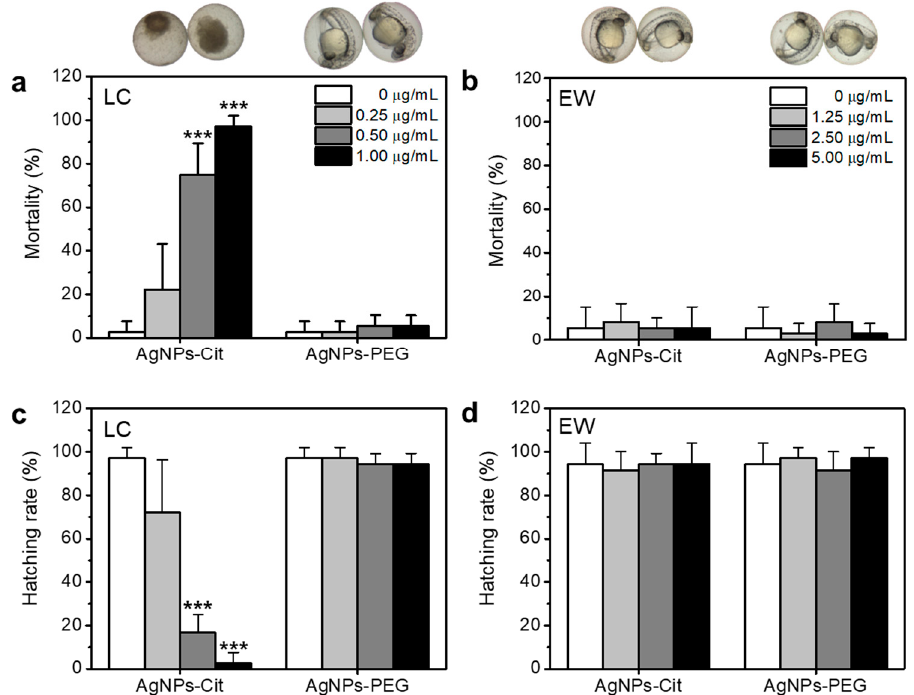
Figure 4. Mortality ( a , b ) and hatching rate ( c , d ) of AgNPs ‐ Cit or AgNPs ‐ PEG treated zebrafish embryos in different media (LC and EW). Each sample was treated at 4 hpf and incubated at 28 °C. Mortality was evaluated at 48 hpf, and hatching rate was observed at 96 hpf. All zebrafish embryos (n = 12, triplicate) were used in this study. The asterisk (***) indicates a significant difference between the treatment group and control ( p < 0.001).